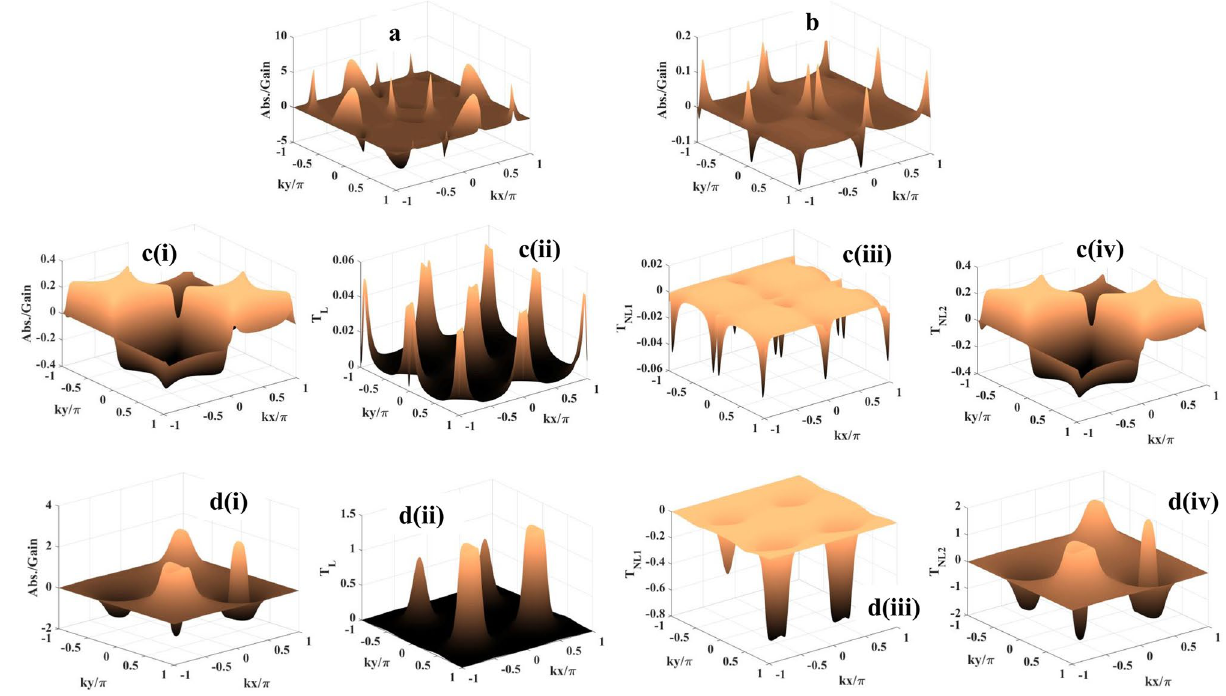
Figure 5. Probe absorption-gain spectra: ( a ) φ = 0, � p = � m = 5 meV, (cid:31) c = − 5 meV; ( b ) φ = 0, � p = � m = � c = 10 meV; ( c ) φ = π/ 2, � p = � m = � c = 10 meV; ( d ) φ = π/ 2, � p = � m = 10 meV, (cid:31) c = − 10 meV. c(ii) [d(ii)] , c(iii) [d(iii)] , and c(iv) [d(iv)] show the respective contribution of T L , T NL 1 , and T NL 2 to the formation of spectrum shown in c(i) [d(i)] . Parameters: R na = R ca = 10 meV, R m = 0.05 meV,